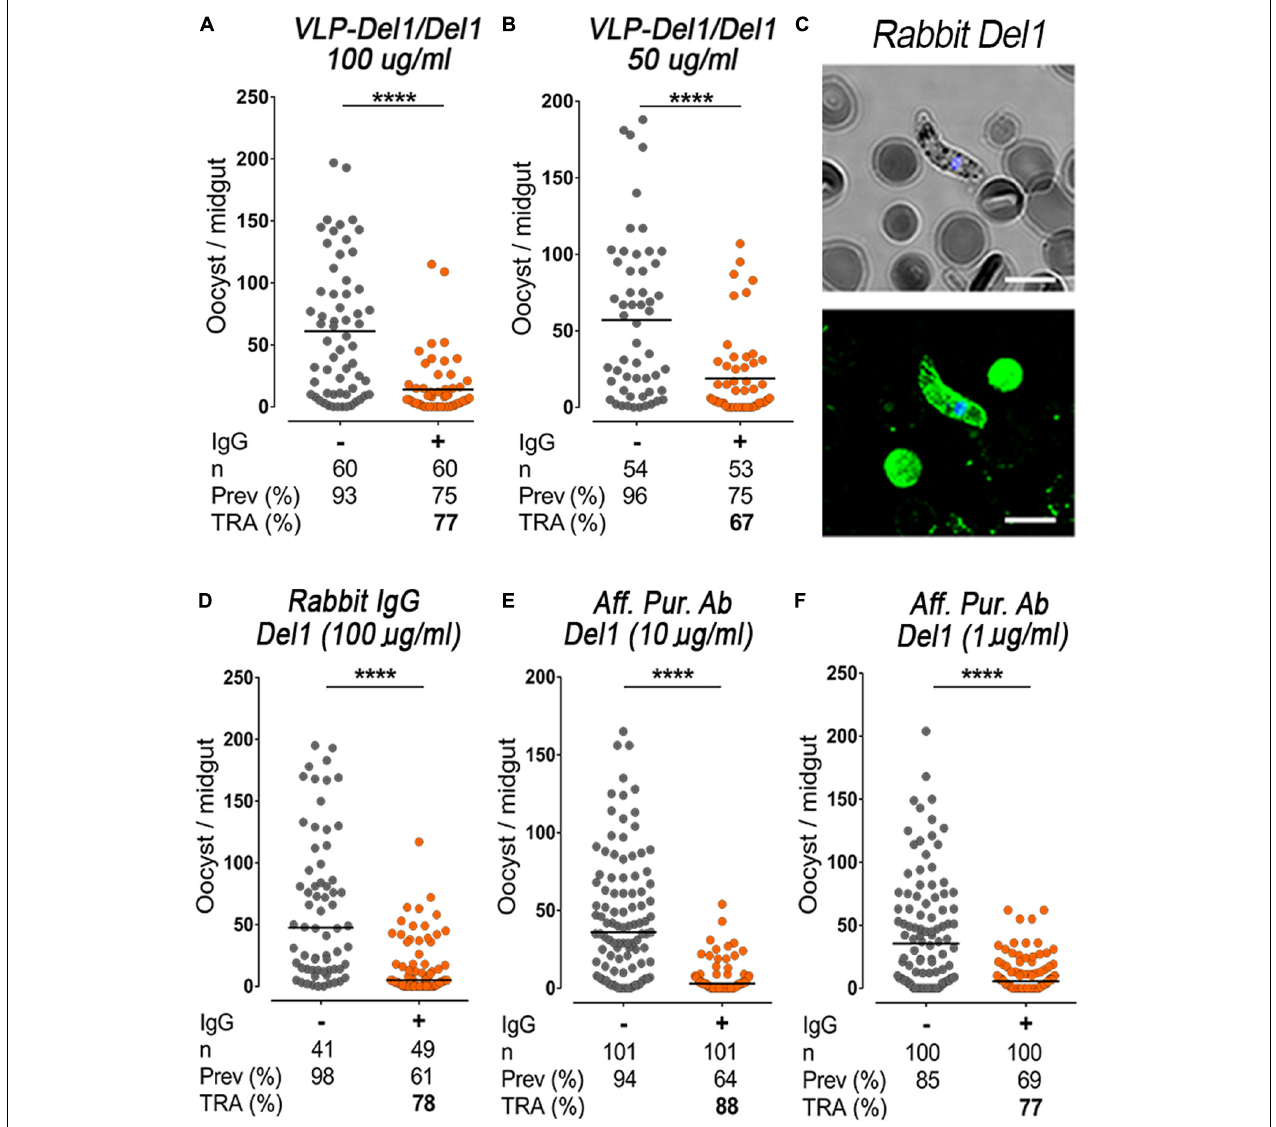
FIGURE 4 | Functional characterization of total sera against Del1 recombinant protein. (A) TRA of VLP-Del1 following direct mosquito feeding on mice passively immunized with 100 µ g/mL and (B) 50 µ g/mL of purified IgG, respectively. (C) Immunofluorescence assay to detect native Pbs47 on Ookinetes. As a negative control, parasites were stained with antibodies from naïve mice (left). Parasites were stained with antibodies derived from rabbit immunization with Del1 in green. DNA was stained with DAPI (blue); Antibody binding was detected by Alexa Fluor 488-conjugated goat anti-mouse or anti-rabbit IgG. DIC view (top) and a merge of DAPI and antibody staining (bottom) are shown. The staining was imaged using a confocal microscope; Scale bar: 2 µ m. (D) TRA of rabbit Del1 IgG following direct mosquito feeding on mice passively immunized with 100 µ g/mL. (E) TRA of rabbit Del1 affinity purified IgG following direct mosquito feeding on mice passively immunized with 10 µ g/mL and (F) 1 µ g/mL of purified IgG, respectively. Each dot represents the number of oocysts in individual mosquito and the lines indicate the medians per group. Number of mosquitoes dissected (n); Infection prevalence (Prev); Transmission-reducing activity (TRA) as percent inhibition of infection intensity relative to naïve control mice. This data represents the overall result from n = 2 replicates. Medians were compared using the Mann–Whitney test: **** P < 0.0001.